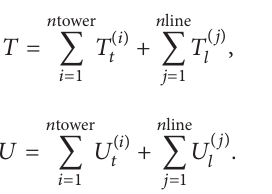
the transmission tower-line system can be developed by combining the 2D tower model and the equivalent line